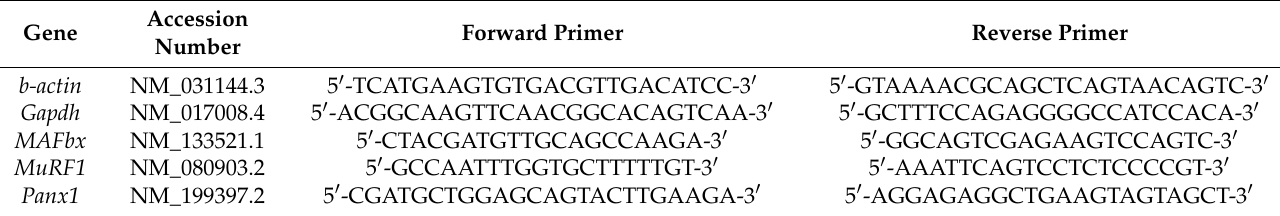
Table 2. Primers used for